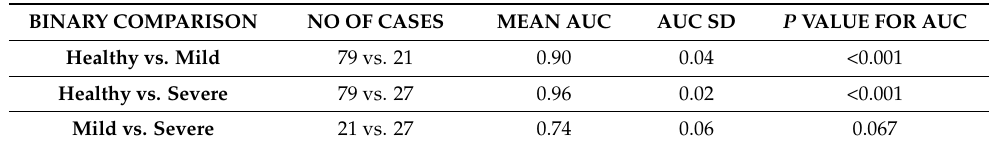
Table 4. Binary comparison of the facial features of POGZ -cohorts with mild and severe phenotypes by using Face2Gene